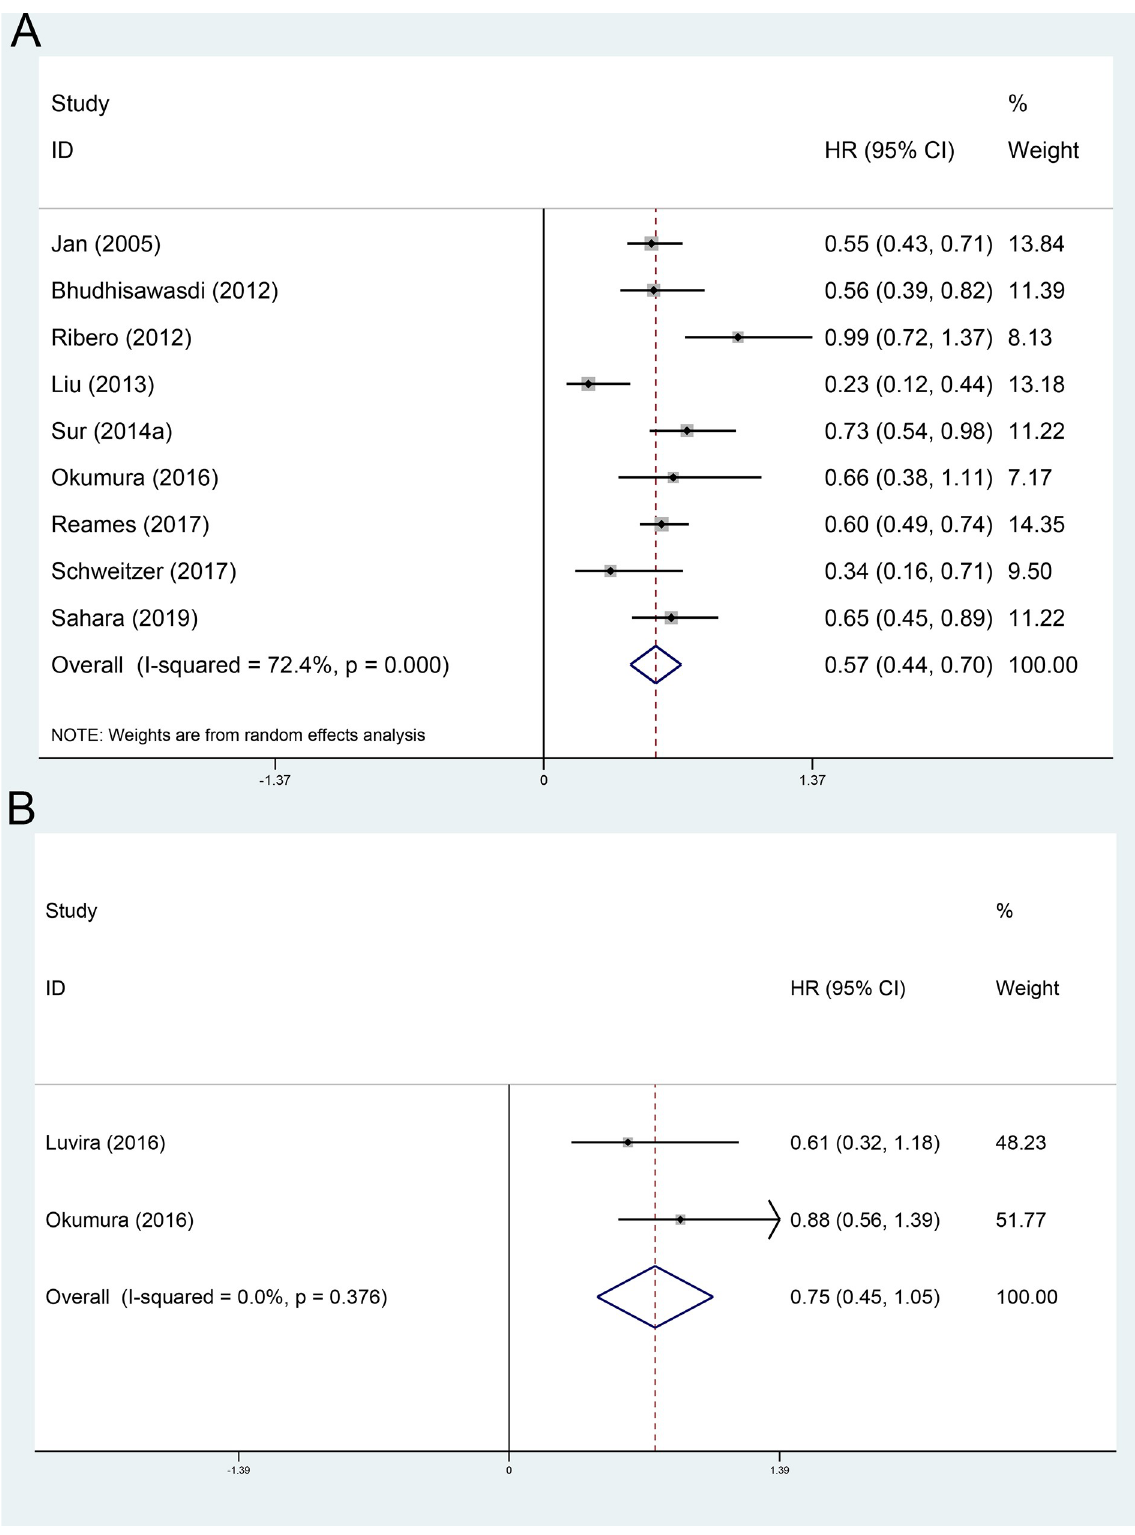
Fig 3. Forest plot of the overall survival and recurrence-free survival rates between adjuvant chemotherapy and operation only. A, overall survival; B, recurrence-free survival.